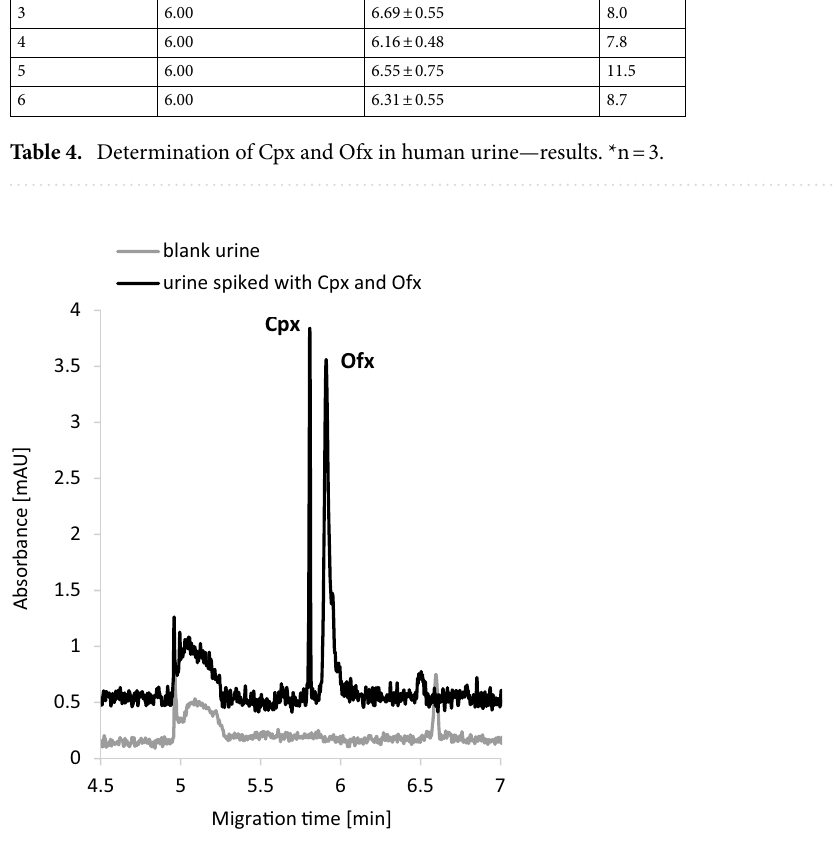
Figure 2. Representative electropherograms obtained for urine and urine spiked with Cpx and Ofx (final concentration 6 nmol/mL